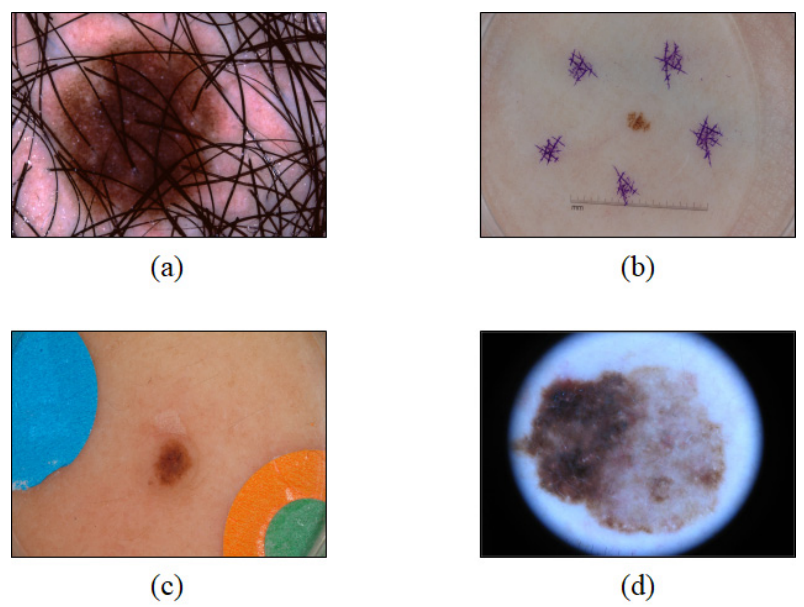
Figure 3. Examples of dermoscopy images excluded from the dataset: images including ( a ) an excessive amount of hair, ( b ) unnecessary marks, ( c ) an unnecessary mark, and ( d ) a great amount of noise.